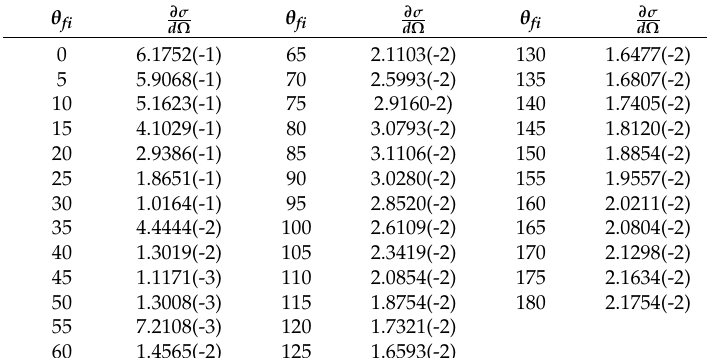
/ sr ) at k = 1.0 at various scattering angles. 0